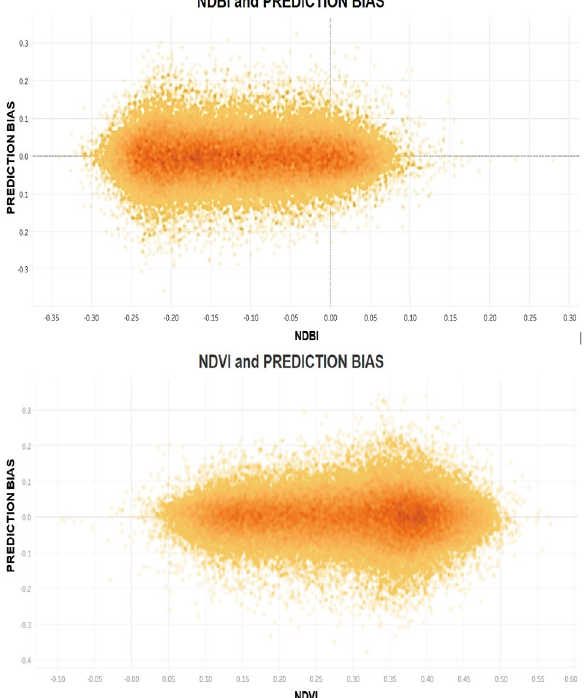
Figure 7. Comparison of observed and predicted UTFVI. The RF models were able to predict the UTFVI intensity especially in the built-up areas. However, some values in certain areas are overestimated while others are underestimated.